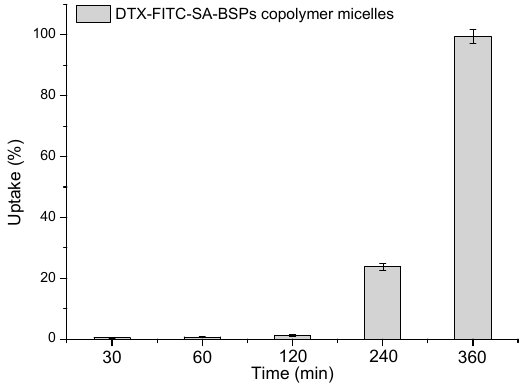
Figure 5. The cellular uptake of DTX-FTIC-SA-BSPs copolymer micelles using flow cytometry assay.